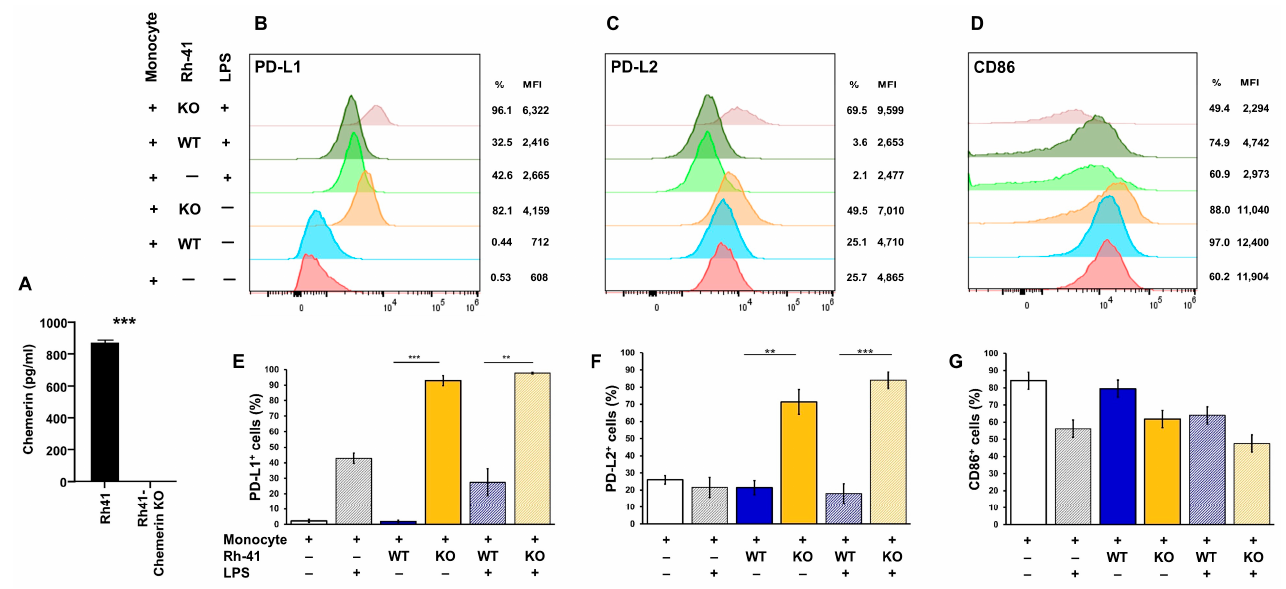
Figure 2. Function of chemerin in RMS. ( A ) Chemerin secretion in parental and chemerin KO Rh41 cells. ( B – G ) Influence of chemerin loss on cocultured monocytes. A total of 6 × 10 5 monocytes, resting or activated with 100 ng/mL LPS, were cocultured with 2 × 10 5 parental (WT) or chemerin-deficient (KO) Rh41 cells for 48 h. ( B – D ) Expression of PD-L1, PD-L2 and CD86 was analyzed by flow cytometry. ( E ) % PD-L1 positive cells. ( F ) % PD-L2 positive cells. ( G ) % CD86 positive cells. Depicted are means ± standard error of measurements of monocytes from 4 different donors. ** p < 0.01, *** p < 0.001, as determined by paired Student’s t -test.